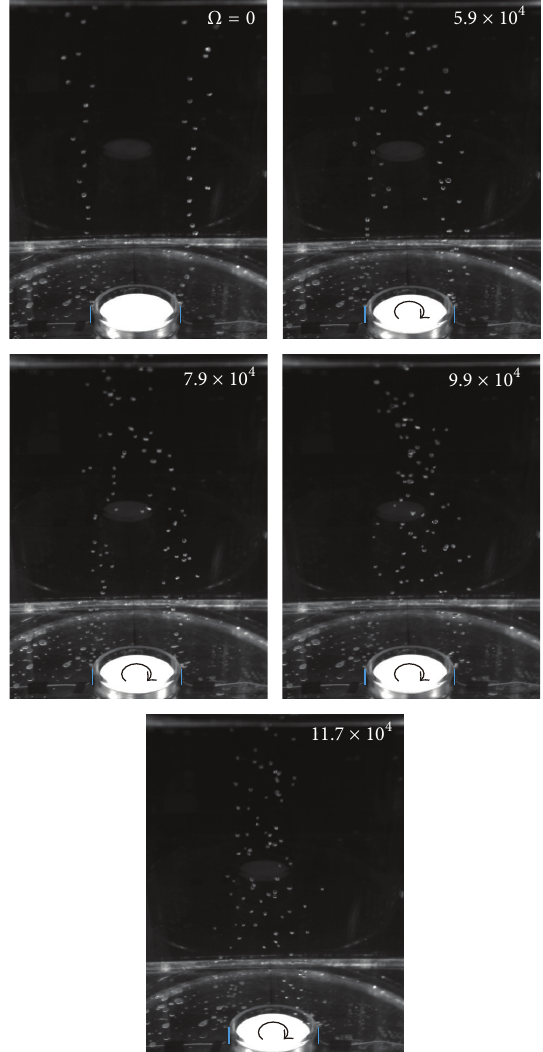
Figure 7: Bubble behavior when 𝑄 𝑔 = 24 mm 3 /s.